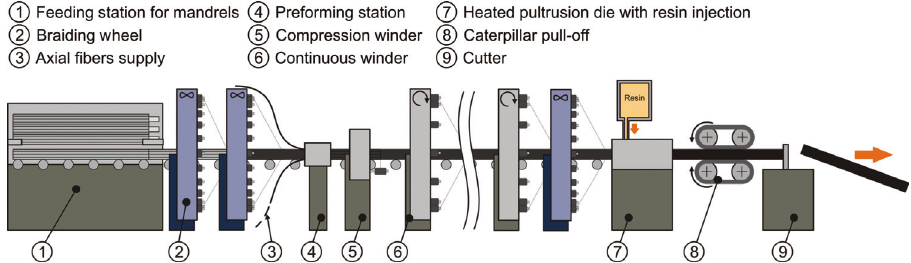
Figure 10 Schematic diagram of the assumed pultrusion facility for cost